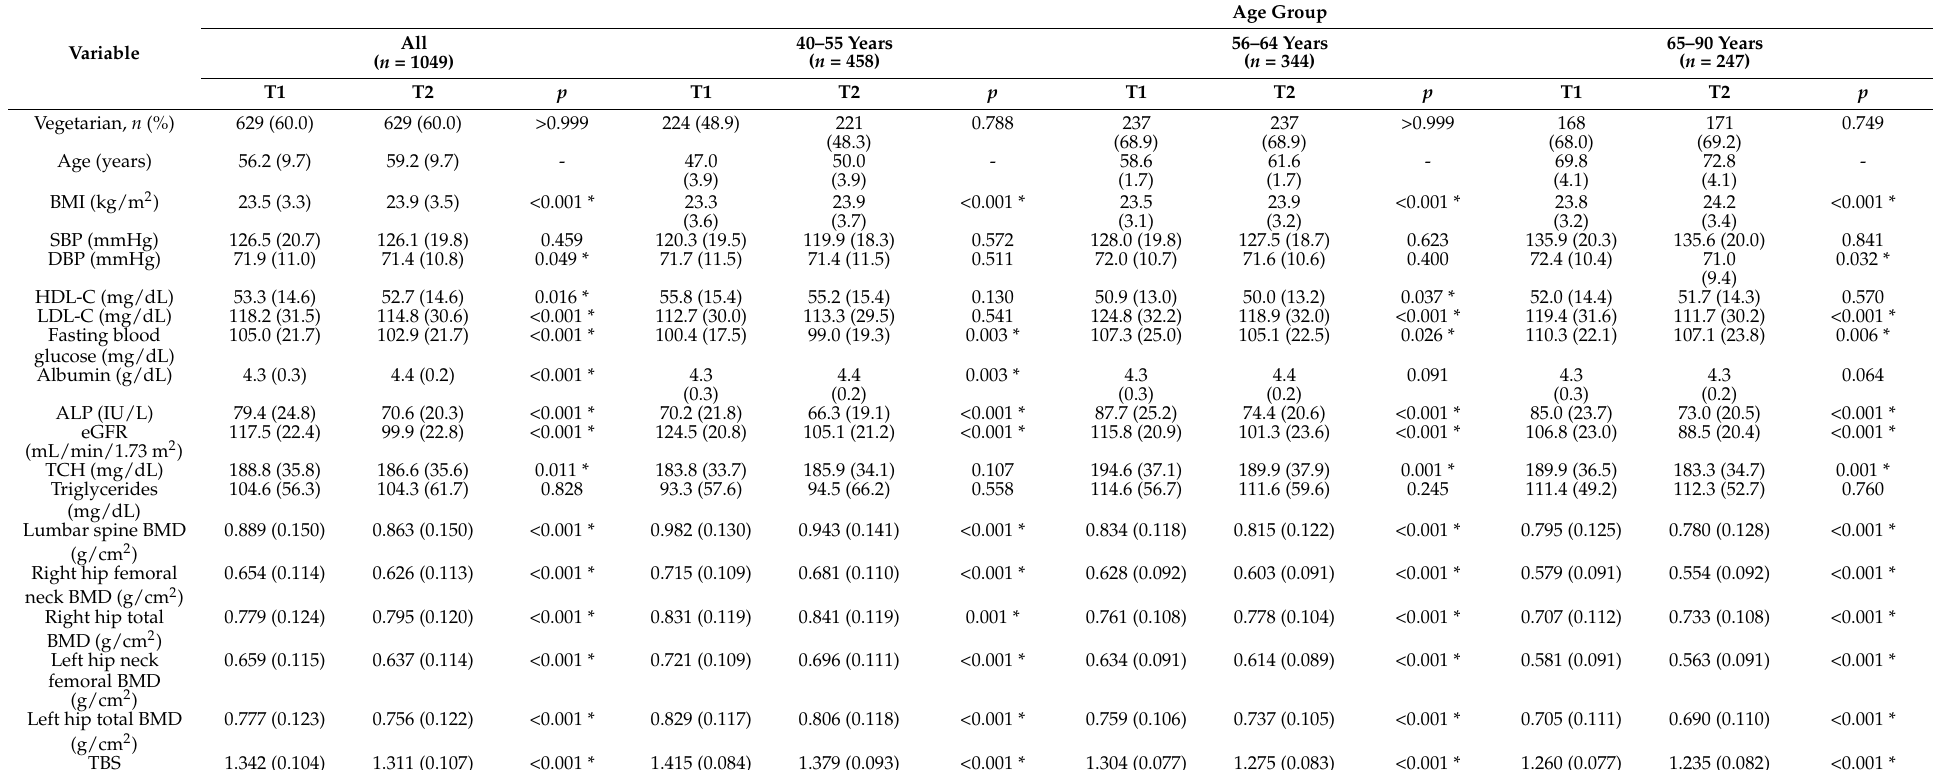
Table 1. The demographic and clinical characteristics of the patients, stratified into three age